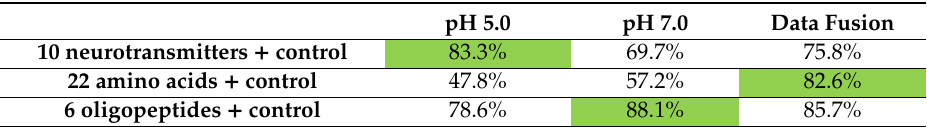
Figure 3. Confusion matrixes of PLS-DA models applied for neurotransmitters identification: ( A ) QDs-assisted 2D fluorescence in pH 5.0; ( B ) QDs-assisted 2D fluorescence in pH 7.0; ( C ) data fusion of ( A , B ). Table 1. Accuracy (percent of correct classifications) of the bioanalytes identification by QD-assisted 2D fluorescence coupled with PLS-DA.